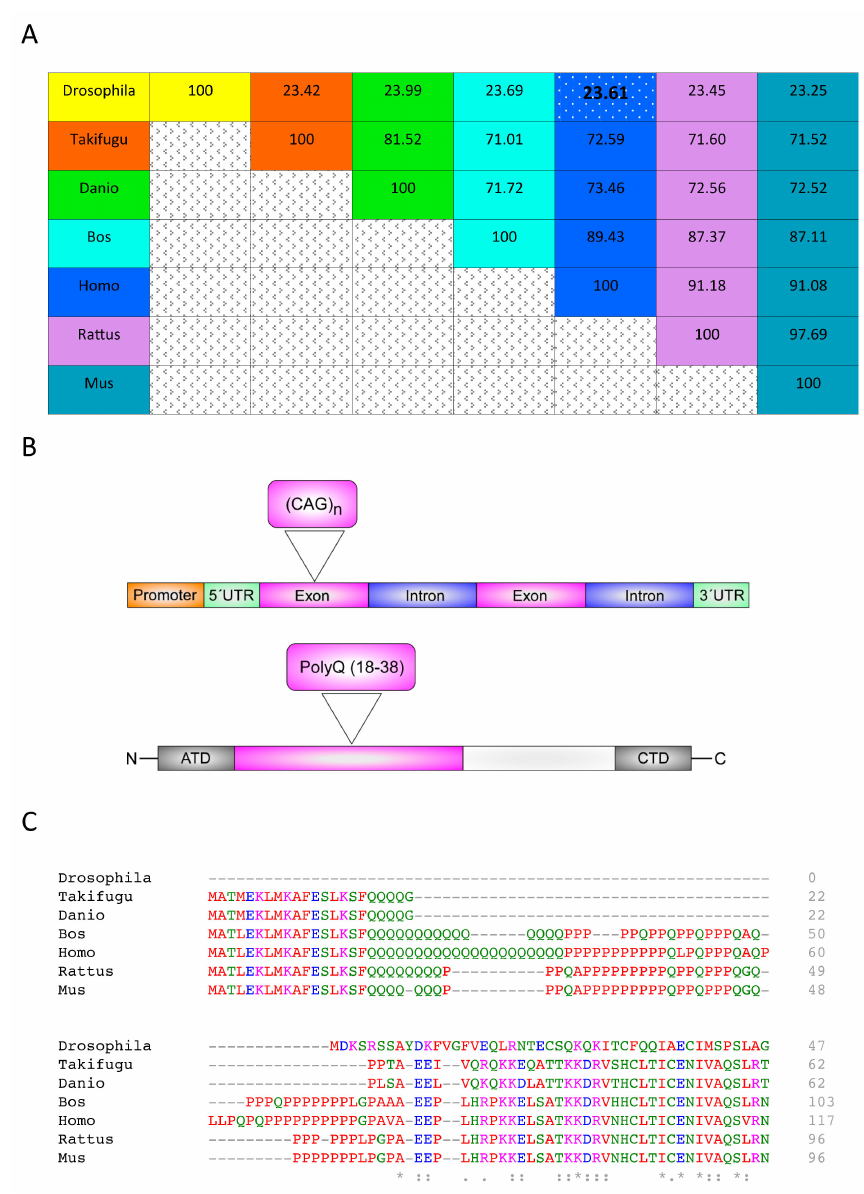
Figure 1. Multiple sequence analysis of huntingtin protein using Clustal Omega. ( A ) Percent identity matrix of the HTT proteins of several species ( Takifugu rubipres in orange; Danio rerio in green; Bos taurus in cyan; Rattus norvegicus in purple; Mus musculus in blue aqua color); the homologies between Homo sapiens (blue) and Drosophila melanogaster (yellow) are highlihted. ( B ) Linearized HTT gene and protein showing the CAG location and polyQ region. ( C ) Multiple sequence analysis of polyQ and polyP repeats of HTT protein. All figures using protein sequences of mammalian ( Homo sapiens , UniProtKB—P42858; Mus musculus , UniProtKB—P42859; Bos taurus , UniProtKB—E1B8E7; and Rattus norvegicus , UniProtKB—G3V9P7), fish ( Danio rerio , UniProtKB—O42269, and Takifugu rubripes UniProtKB—P51112), and fruit fly ( Drosophila melanogaster , UniProtKB—Q9V3N4) species. An asterisk ( * ) indicates positions which have a single, fully conserved residue. A colon ( : ) indicates conservation between groups of strongly similar properties. A period ( . ) indicates conservation between groups of weakly similar